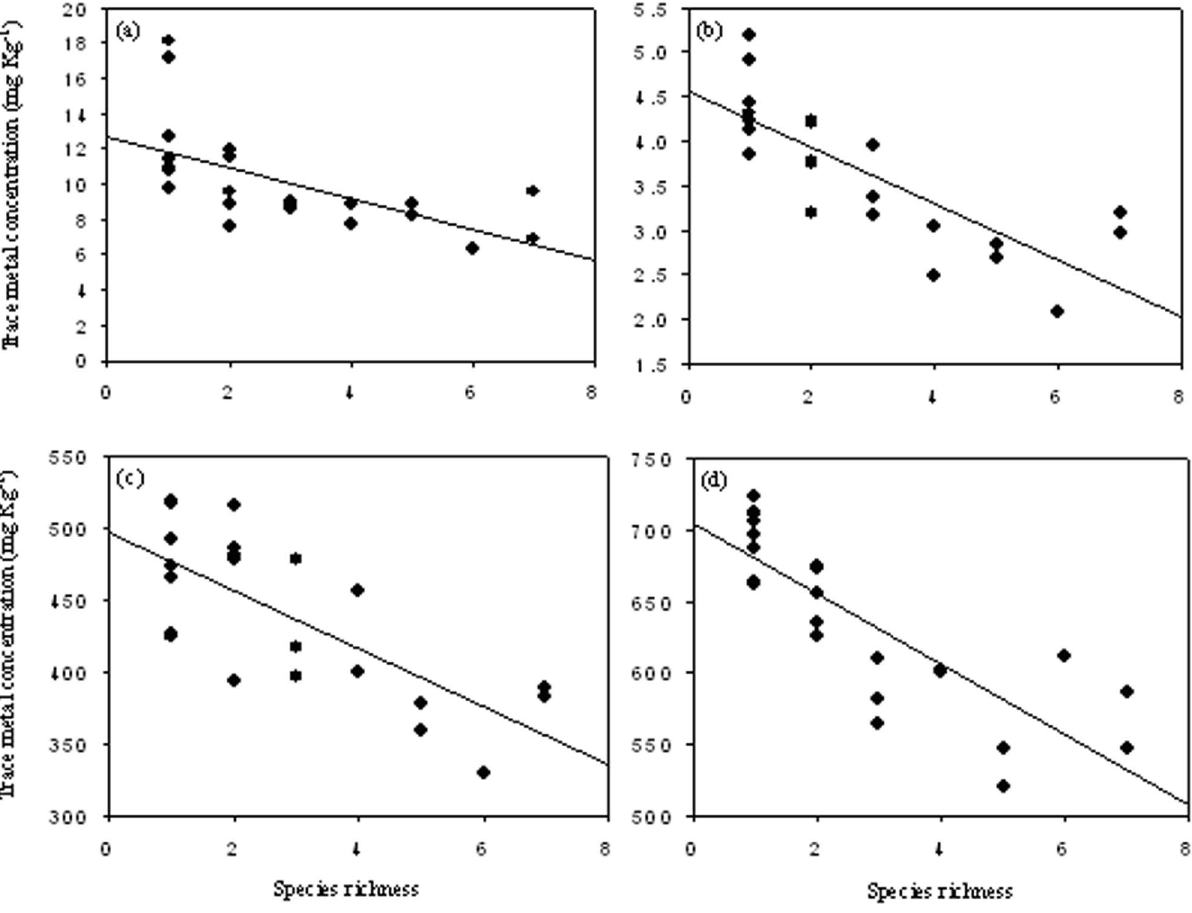
Figure 2. The dependence of soil trace metal concentration (TY) on the actual species richness (SR) in the experimental plant communities. (a) Fitted line: TY Cu =12.655 2 0.610 SR, n =23, P , 0.001. (b) Fitted line: TY Cd =4.547 2 0.796 SR, n =23, P , 0.001. (c) Fitted line: TY Pb =496.414 2 0.735 SR, n =23, P , 0.001. (d) Fitted line TY Zn =703.839 2 0.818 SR, n =23, P , 0.001.